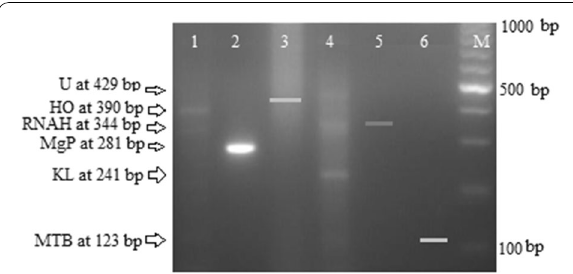
Fig. 1 The genes amplified from urogenital pathogens on 1.5% agarose gel electrophoresis; Lane M: 100 bp DNA